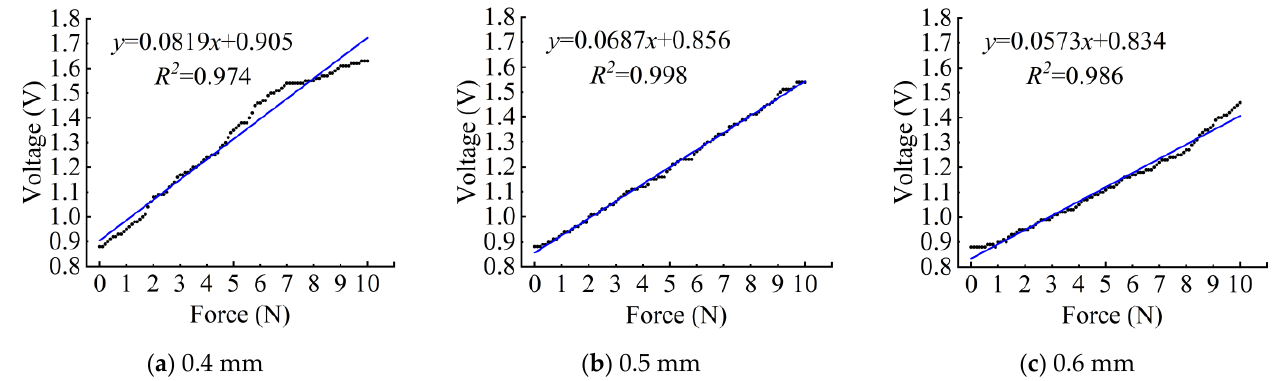
Figure 10. Gripper detection system calibration curve: ( a ) elastic actuator with a thickness of 0.4mm calibration curve; ( b ) elastic actuator with a thickness of 0.5mm calibration curve; ( c ) elastic actuator with a thickness of 0.6mm calibration curve.